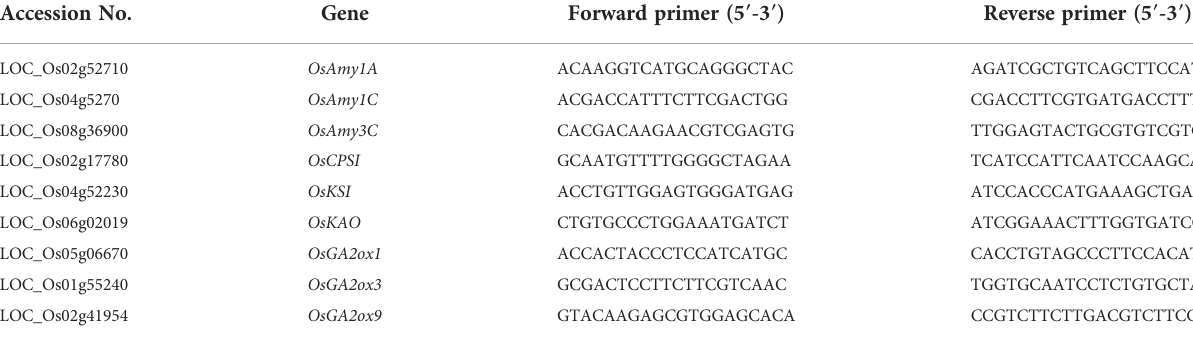
TABLE 1 Primer list for quantitative real-time PCR analysis. Accession